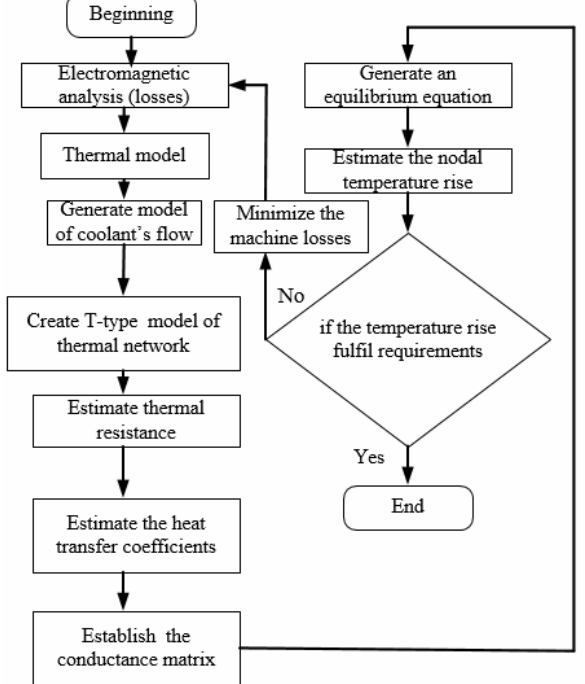
Figure 6. Flow diagram of the temperature rise estimation methodology [31].